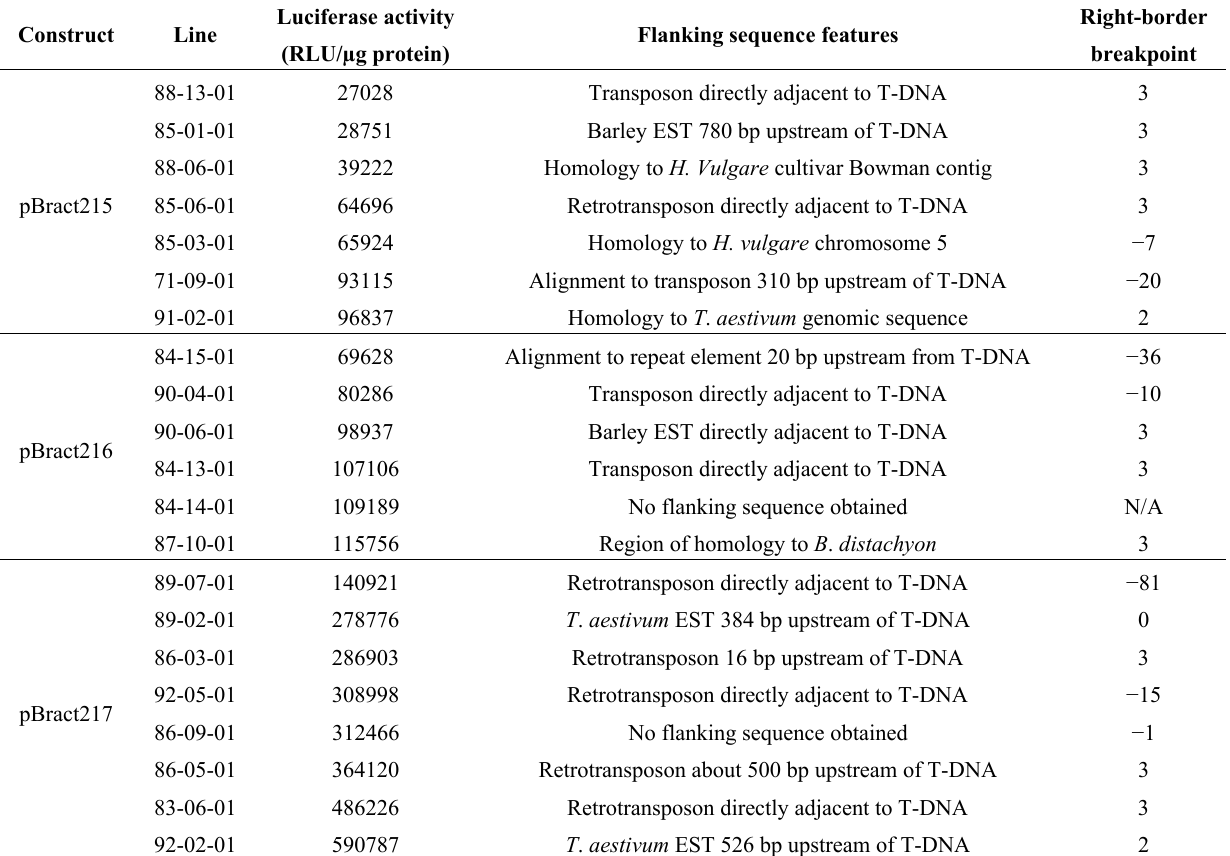
Table 4. T-DNA insertion site compared to luciferase activity. For each construct the lines are listed in order of ascending luciferase activity. The flanking sequence features are summarised from those shown in Figure 3. The right-border (RB) breakpoint corresponds to the number of base pairs of sequential construct DNA present within the plant genome beyond the start of the RB repeat